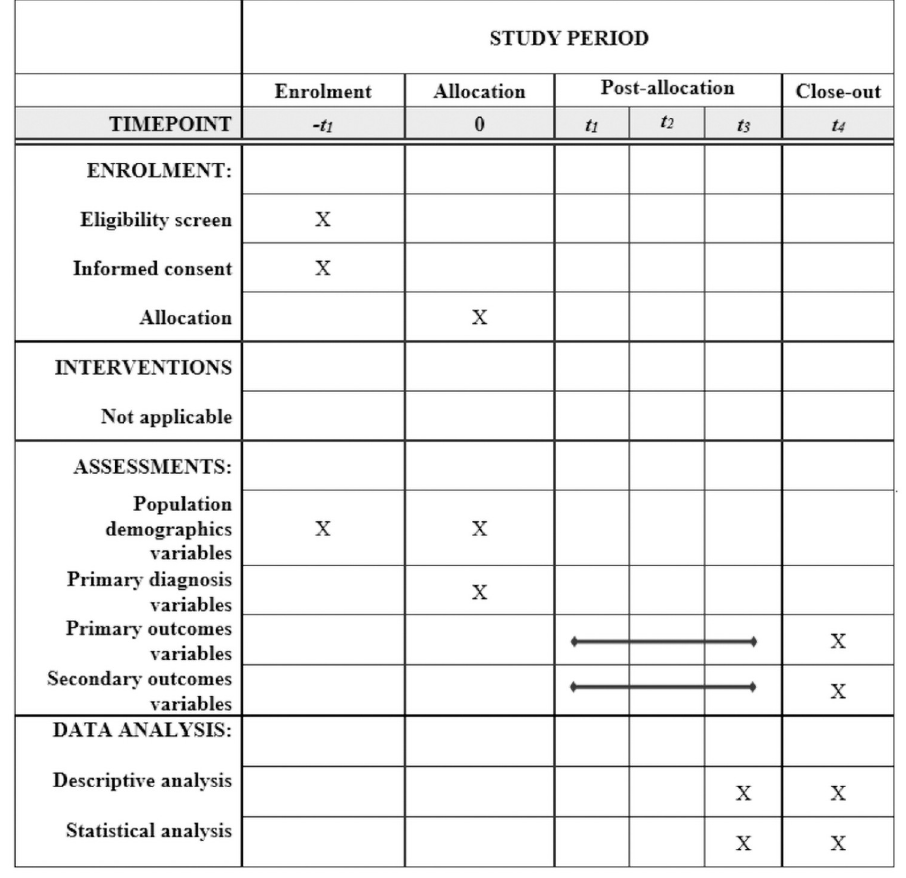
Fig 1. Schedule of enrollment, interventions, and